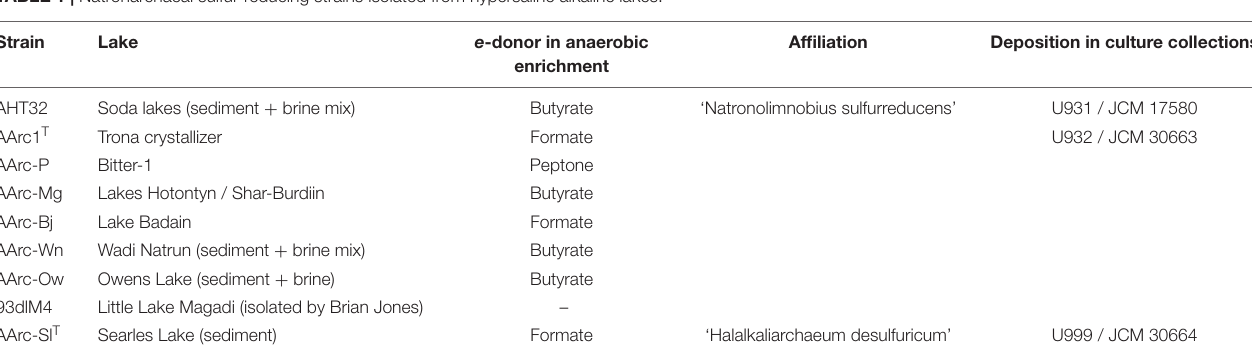
( Supplementary Figure S2 ). The aerobically cultivated